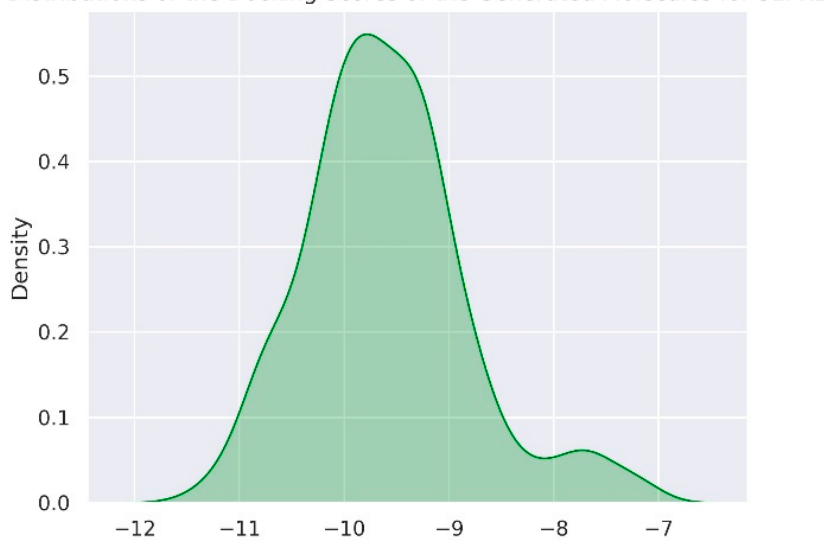
Figure A3. Example of generated molecules for target HTR1A.